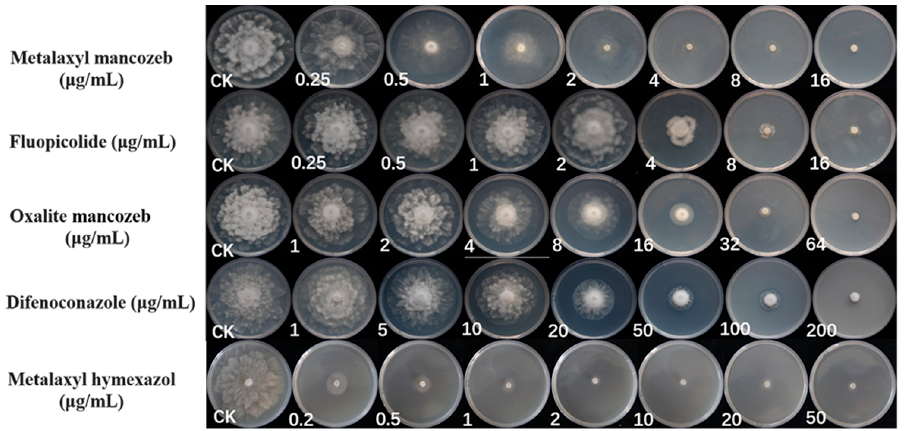
Figure 7. Symptoms on 2-year-old camphor after inoculation with isolate ZS01. ( A ) Control treated with sterile V8 liquid. ( B – E ) Diseased sapling, with symptoms at 14 days, 21 days, 28 days and 35 days post inoculation. ( F ) Control roots and roots of diseased saplings. ( G , H ) Control longitudinal section and longitudinal section from the stem of a diseased sapling 40 days after inoculation with ZS01. ( I , J ) Control longitudinal section and longitudinal section of the root of a diseased sapling 38 days after inoculation with ZS01. Dpi: days post inoculation.